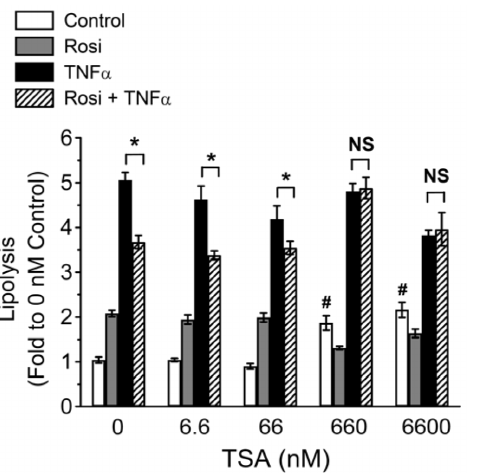
Figure 2. TSA attenuates Rosi-mediated suppression of TNF a - induced lipolysis in a dose-dependent manner. 3T3-L1 adipo- cytes were treated with vehicle (Control), 1 m M Rosi (Rosi), 10 ng/ml TNF a (TNF a ), or both (Rosi + TNF a ), together with increasing TSA doses (0, 6.6, 66, 660, 6600 nM) for 24 h. Glycerol released into the media and protein concentrations of cell lysate were determined as described in Materials and Methods . Each point represents the mean 6 S.E. of three independent experiments. Asterisks denote significant differences (p , 0.05). NS, not significant. # p , 0.05 vs 0 nM control.